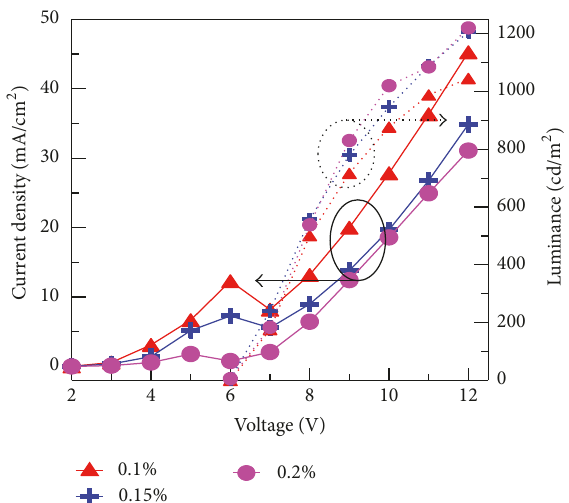
Figure 8: Current density and luminance characteristics as a function of the applied voltage.